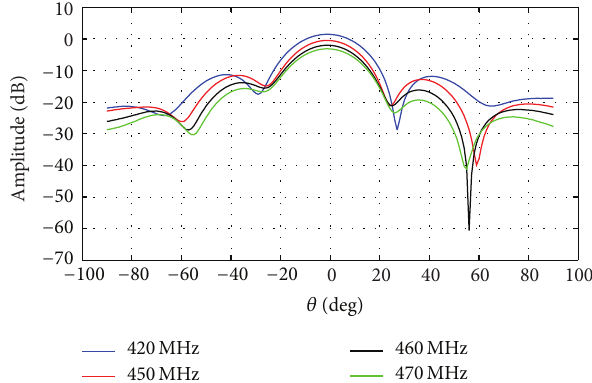
Figure 6: Return loss of SAR-Low antenna: comparison between simulation and measurement.